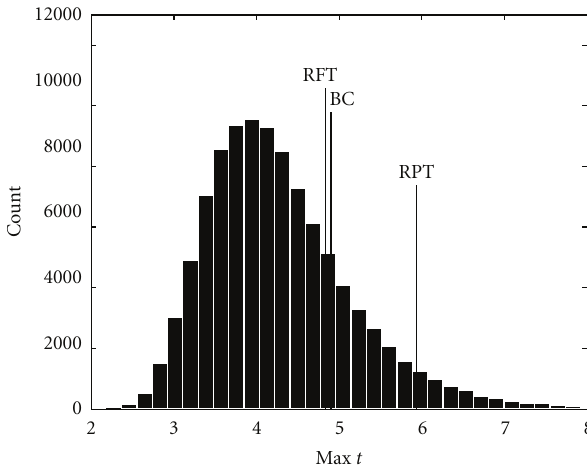
Figure 11: The estimated null distribution of the maximum t - test value from the GLM, when 8mm smoothing was applied. The calculated thresholds for corrected P = 0.05 for the three approaches are marked with BC (Bonferroni correction), RFT (random field theory), and RPT (random permutation test).